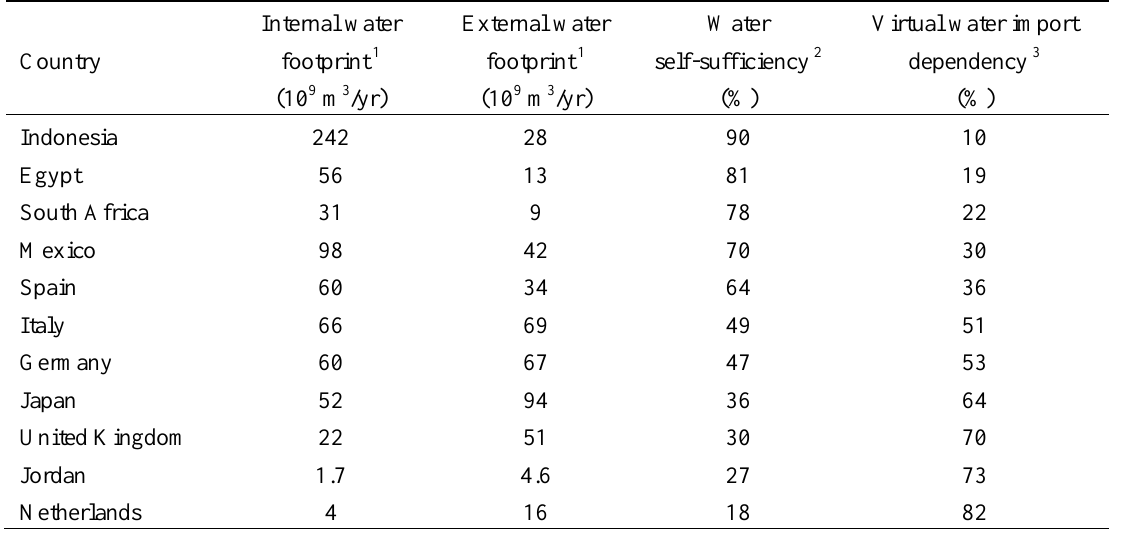
Table 3. Virtual water import dependency of some selected countries. Period: 1997–2001.